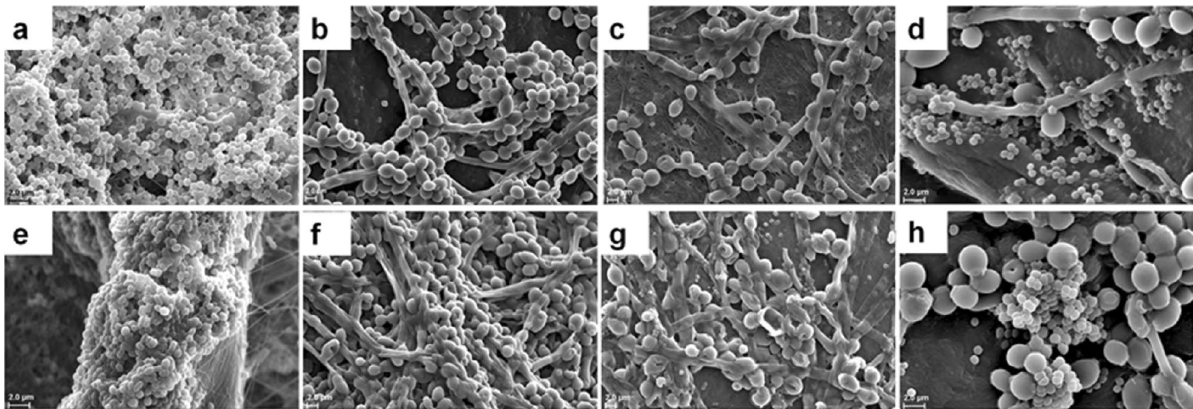
Figure 5. Visualisation of monomicrobial and polymicrobial biofilms of S. epidermidis and C. albicans on human cadaveric cornea using scanning electron microscopy. S. epidermidis biofilm at 24 h ( a ), C. albicans biofilm at 24 h ( b ), polymicrobial mixed biofilm of S. epidermidis and C. albicans grown simultaneously for 24 h ( c ), preformed biofilm of S. epidermidis for 24 h to which C. albicans was added ( d ), S. epidermidis biofilm at 48 h ( e ), C. albicans biofilm at 48 h ( f ), polymicrobial mixed biofilm of S. epidermidis and C. albicans grown simultaneously for 48 h ( g ) and preformed biofilm of C. albicans for 24 h to which S. epidermidis was added ( h